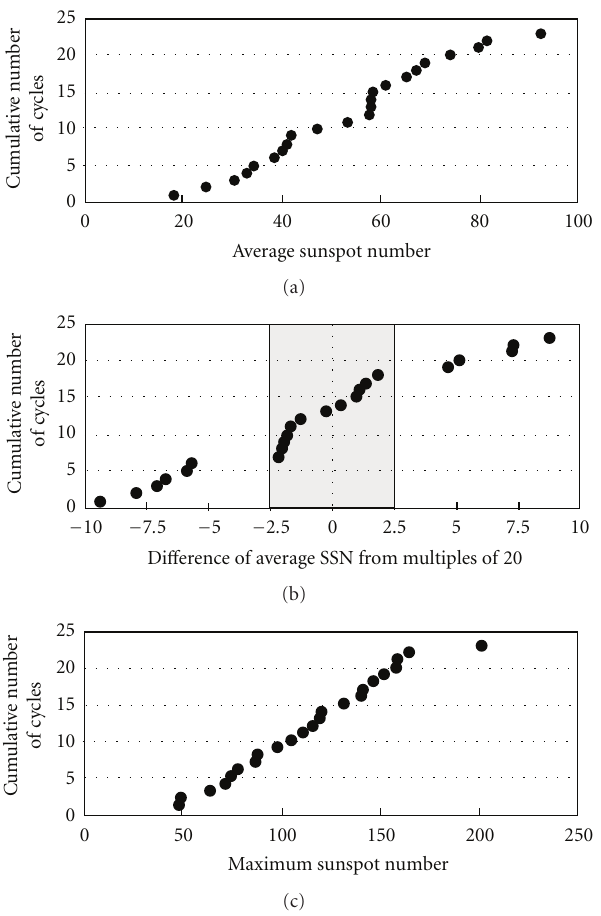
Figure 5: (a) Cumulative number of cycles in order of the average sunspot number over a cycle. (b) Cumulative number of cycles in order of the di ff erence of the average sunspot number from the nearest multiple of 20. (c) Cumulative number of cycles in order of the maximum sunspot number. In Figures 5, 7, 8, and 9 the average sunspot number is obtained by dividing the solar cycle three years before the minimum.